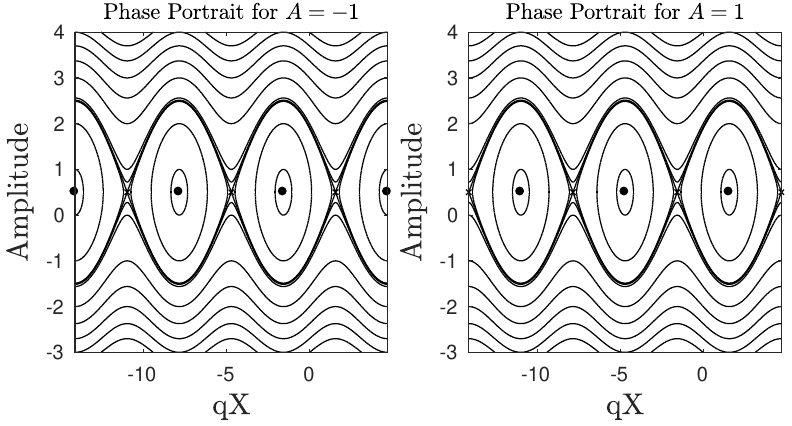
Figure 1. Phase portraits for the dynamical system (15) for ∆ = − 1. Circles correspond to centers and crosses to saddles of the dynamical system